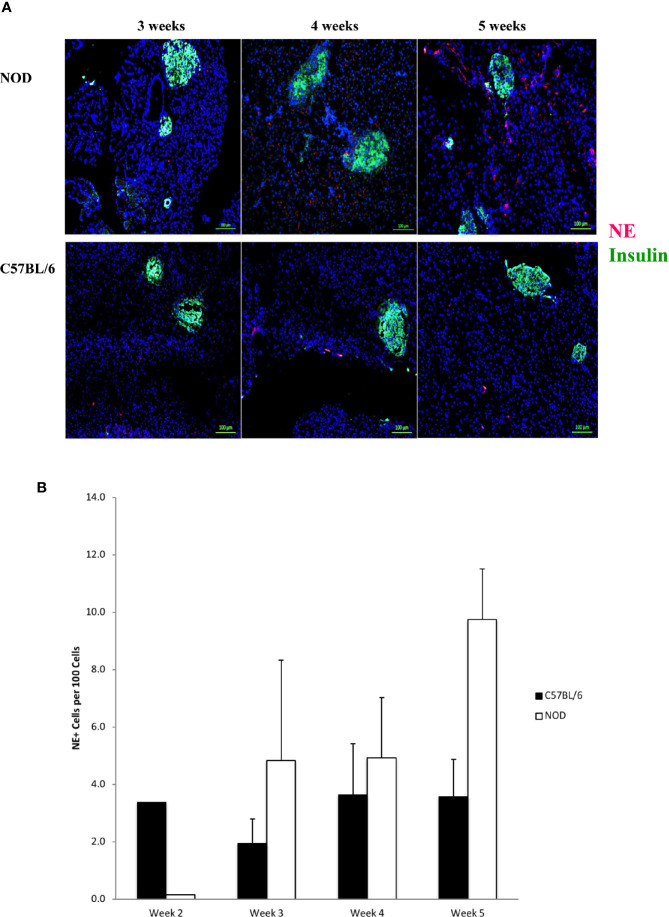
Neutrophil elastase positivity is evident at 4 weeks of age but does not co-localize within islets. (A) Serial sections from formalin-fixed paraffin-embedded pancreata of 3-5 week old female NOD and C57BL/6 mice were stained with fluorochrome-tagged antibodies to insulin and neutrophil elastase (NE). Immunofluorescence shown is representative of outcomes observed in at least three individual mice of each strain. Bar at the bottom of each image represents the length of 100 μm. (B) Quantification of NE+ signals in serial sections from post-natal pancreas of NOD female and C57BL/6 female mice. The number of NE+ events and DAPI nuclear stain were determined using the QuPath Software version 0.1.2. Means of positive signals, following autofluorescence removal, were determined among three to five slides per pancreas per antibody target and presented graphically as the number of marker-positive cells per 100 total cells. The differences among ages did not reach statistical significance by ANOVA and neither did difference between NOD and C57BL/6 mice at specific ages (Student’s t-test).